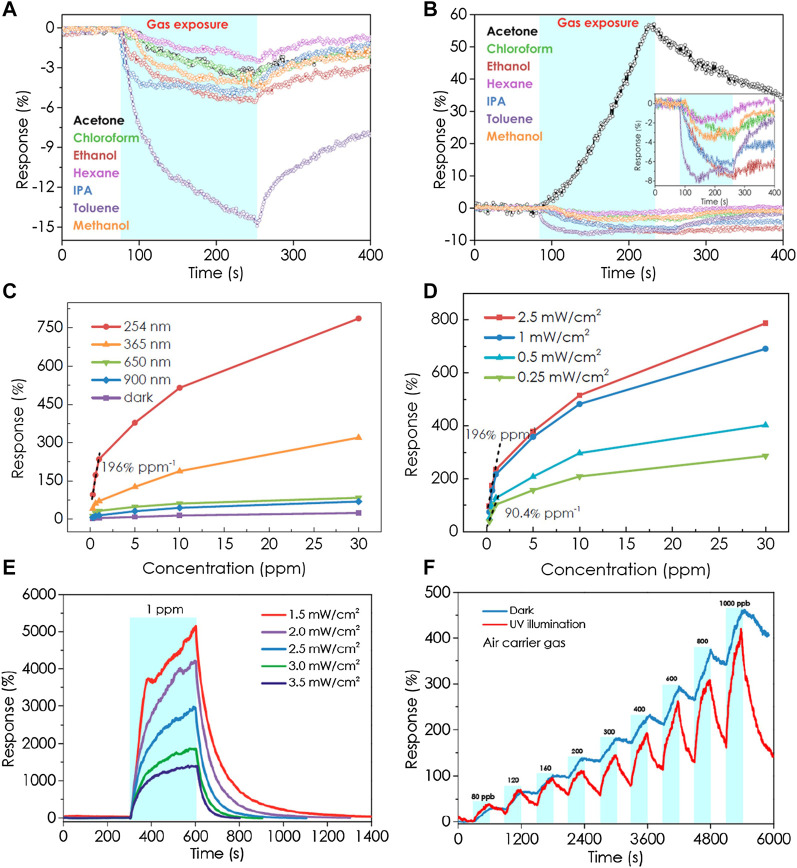
Light-enhanced VOC sensing of MoTe2. (A) shows the response of an MoTe2 FET sensor toward several VOCs at 100 ppm with no light illumination, while (B) shows the responses when the sensor was illuminated with 254 nm UV light. Reprinted with permission from (Wu et al., 2018a). Copyright 2018 American Chemical Society. (C) shows the dependence between response, concentration, and the wavelength of light illumination for an MoTe2 sensor exposed to NH3, and (D) shows the dependence between response, concentration and illumination intensity at 254 nm for the same sensor and analyte. Reproduced from (Feng et al., 2017b). (E) shows the response of an MoTe2 sensor exposed to NO2 and 254 nm UV illumination at different light intensities, and (F) shows the response transients toward NO2 under no illumination and 254 nm UV illumination. Reprinted with permission from (Wu et al., 2018b). Copyright 2017 American Chemical Society.